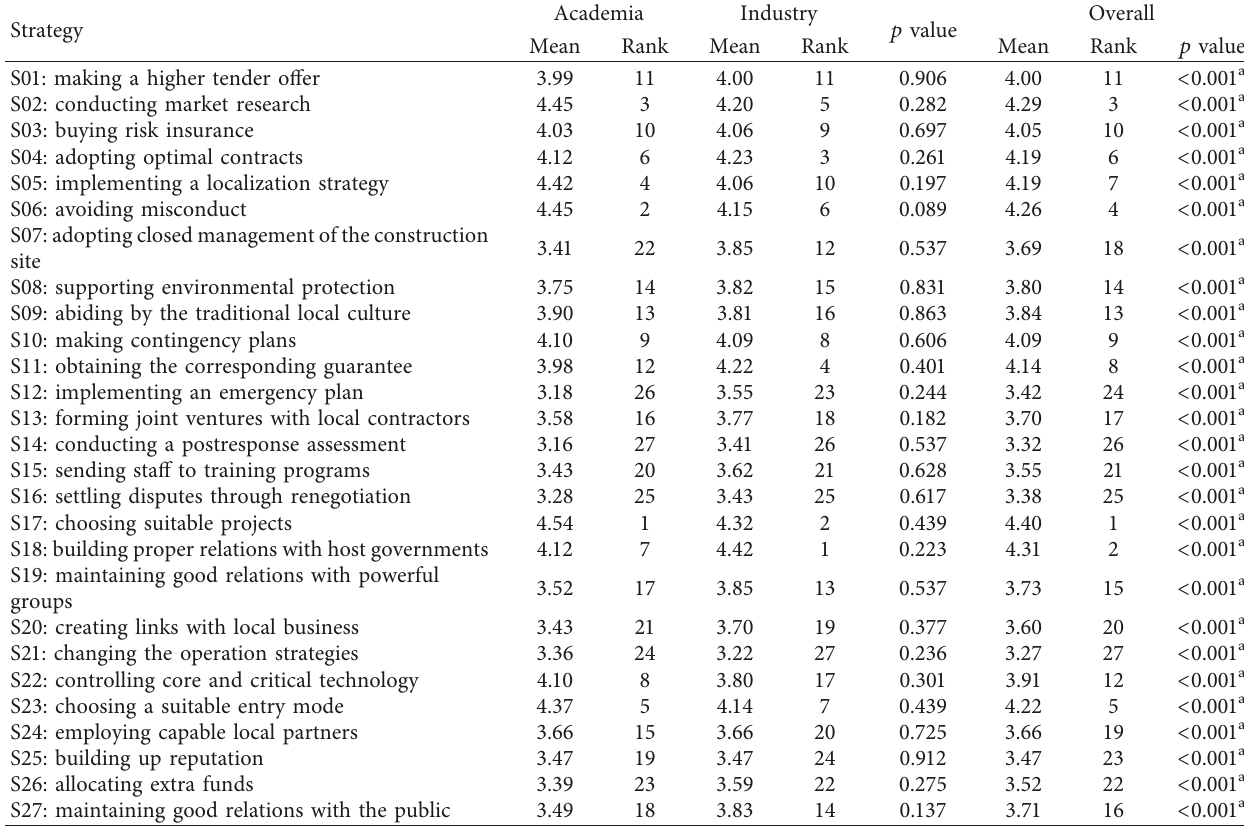
Table 3: Ranking of the political risk management